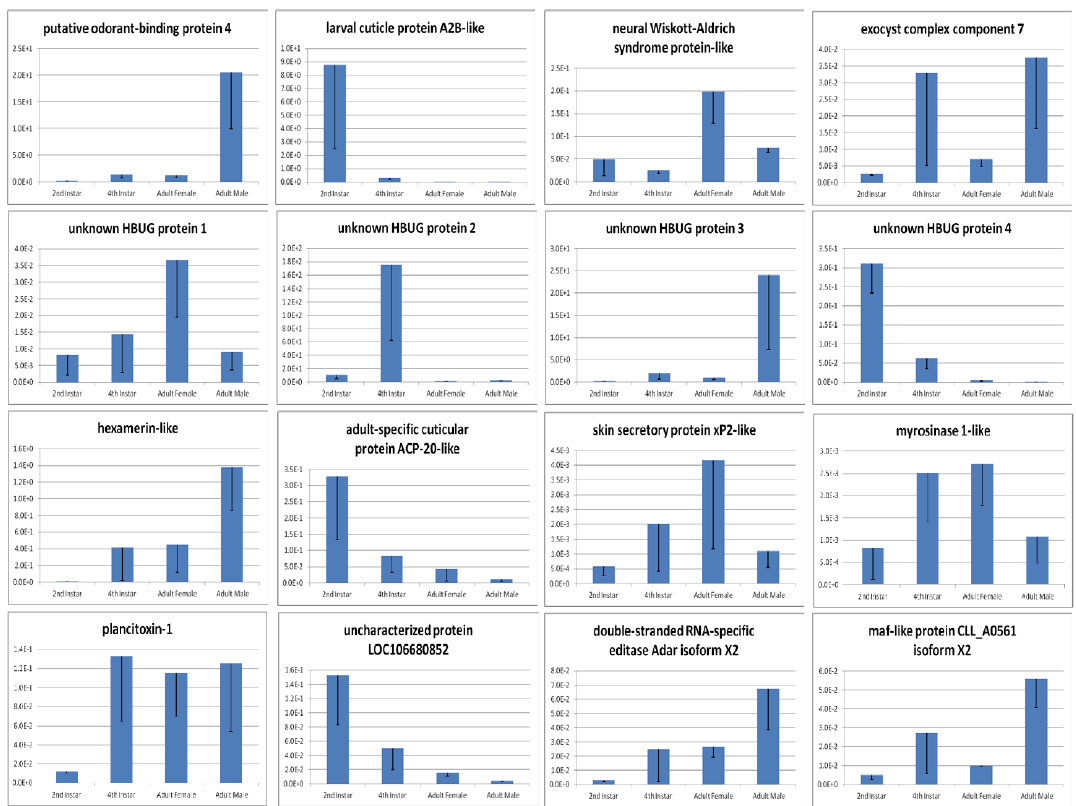
Figure 2. Quantitative real-time PCR validation of select harlequin bug transcript expression patterns.